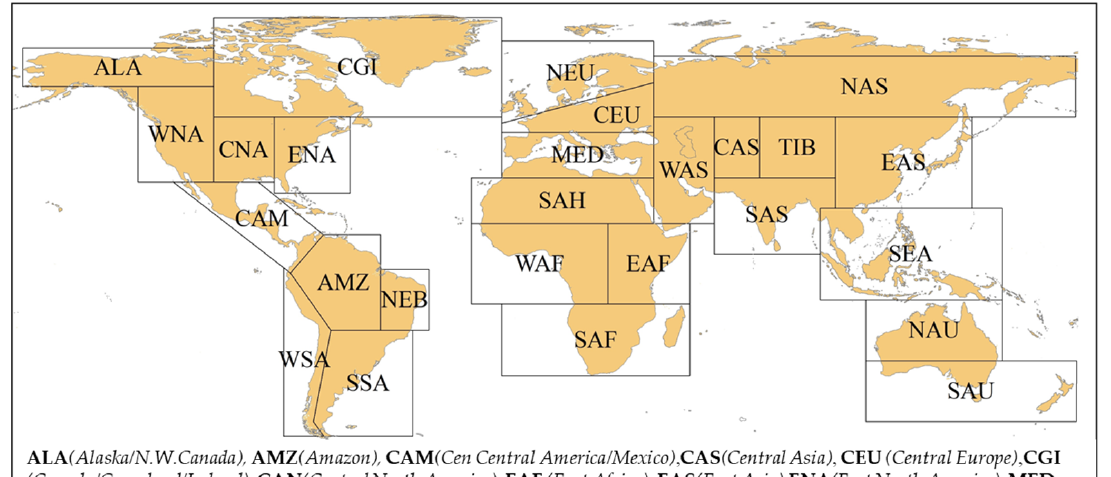
Figure 1. The global division scheme of the 26 IPCC-SREX.